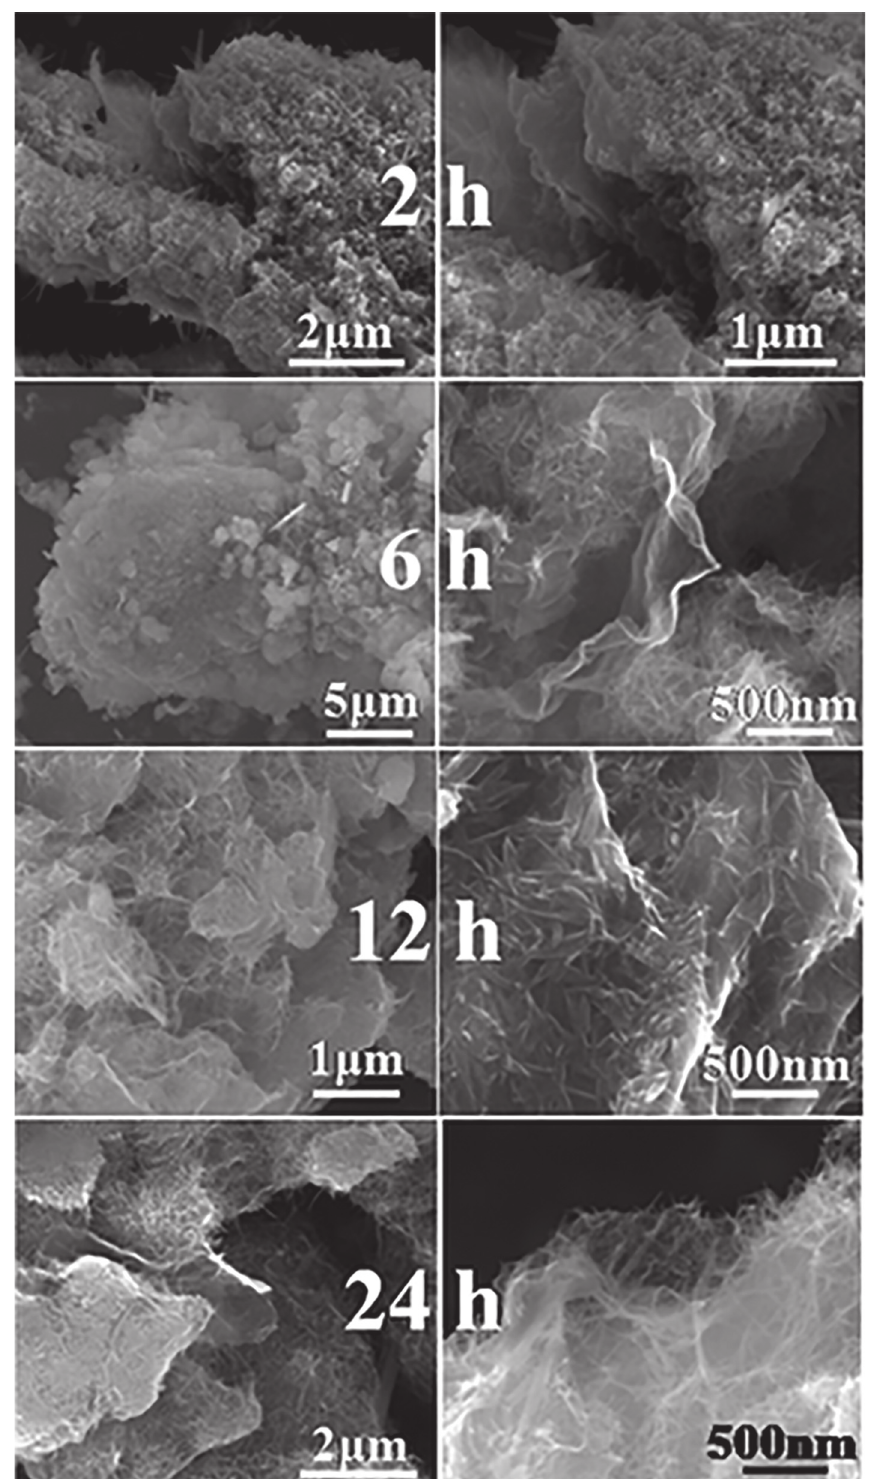
Figure 5: The SEM images of the samples obtained at different reaction times. (a)-(b) 2h. (c)-(d) 6h. (e)-(f) 12 h. (g)-(h)